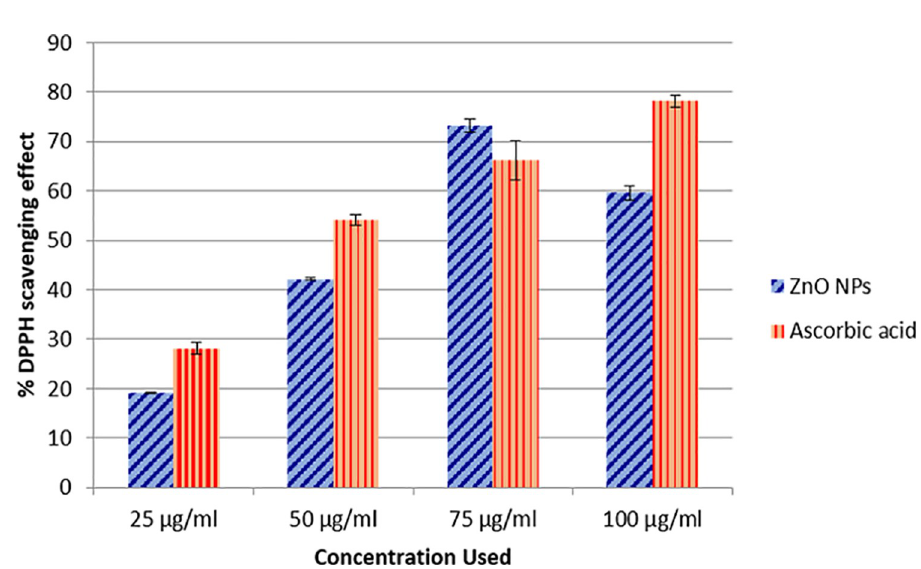
Fig 8. % scavenging activity of green synthesized zinc oxide nanoparticles (ascorbic acid was used as standard). Values are presented as Mean ± Standard error; each experiment was performed in triplicates.